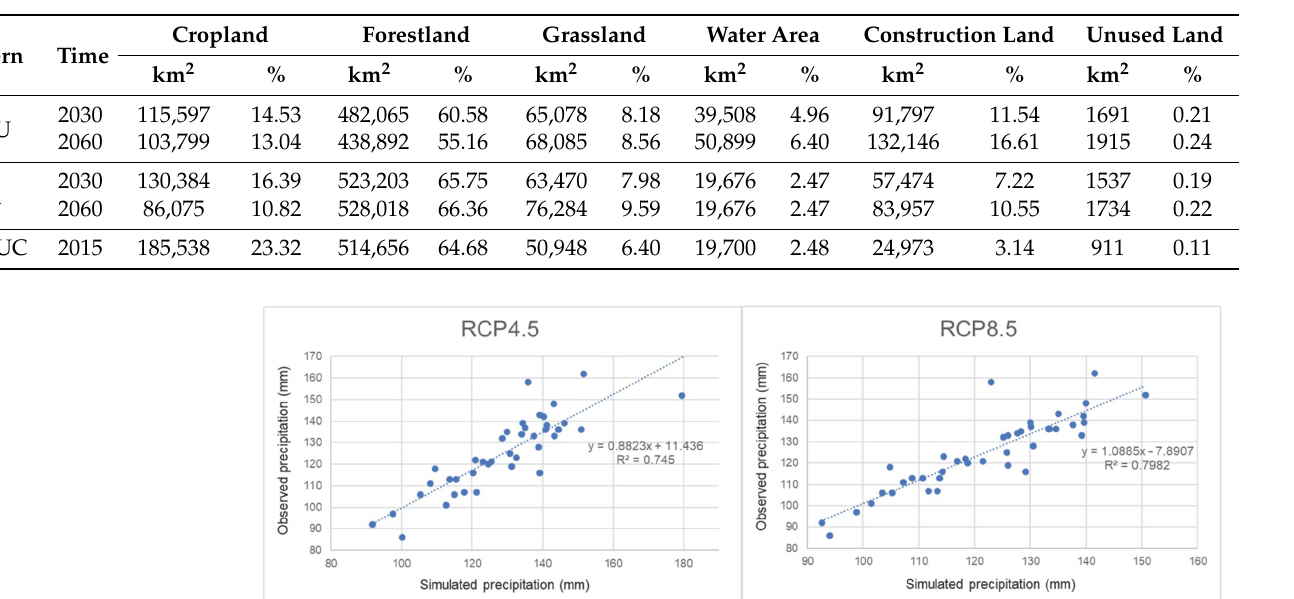
Table 2. Comparison of land use type areas under three LUC patterns.